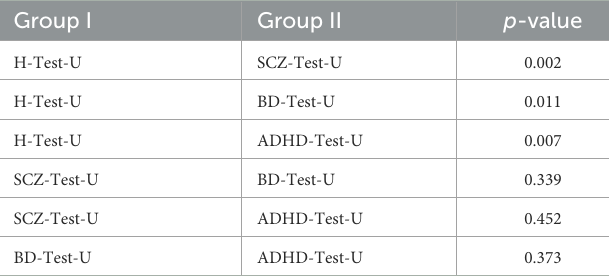
TABLE 3 Mann–Whitney test between the MSE s values data of the groups of